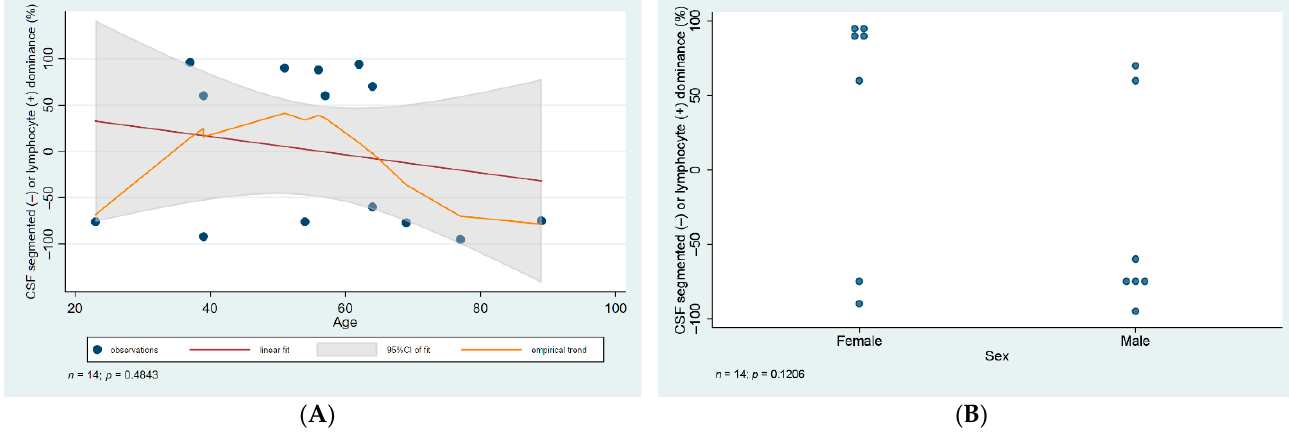
Figure 2. Statistical analysis of CSF cell type. ( A ) Scatter plot of CSF cell type against age with linear regression fit and empirical trend superimposed. ( B ) Categorical scatter plot of CSF cell type by sex. CSF—cerebrospinal fluid; CI—confidence interval. Data of cell type analysis was not available in the case of 9 patients.